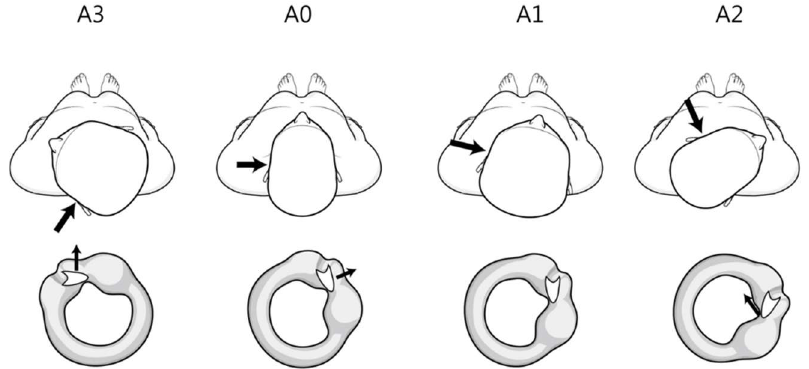
Figure 3. Theoretical findings of the anatomical direction of the cupula (from lateral to medial) during the head roll test in left persistent direction-changing positional nystagmus. The large and small arrows indicate the lesion side and direction of cupula movement, respectively. The left horizontal canal and cupula viewed from the front. A0 (supine position) cupula lateral to medial position. A1 (null plane) rotated 20–30° to the right (opposite side of the lesion). Cupula parallel to the vertical axis A2 (head turning to the right, opposite side of the lesion) rotated an additional 40–50°. Cupula 40–50° downward from the vertical axis. A3 (head turning to the left, lesion side) Cupula 90–100° to the vertical axis.